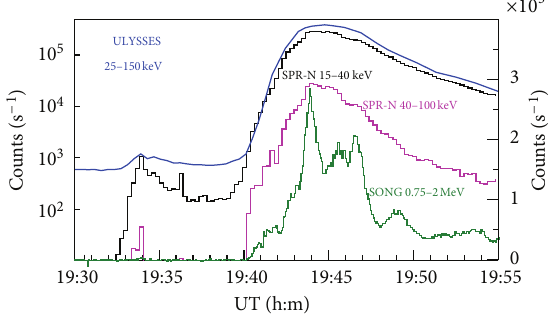
Figure 6: Time profiles of selected emissions from the November 4, 2003, flare measured by Ulysses and CORONAS-F. Left 𝑦 -axis is suitable to Ulysses and SPR-N (15–40keV) data; right 𝑦 -axis to SPR- N (40–100 keV) and SONG